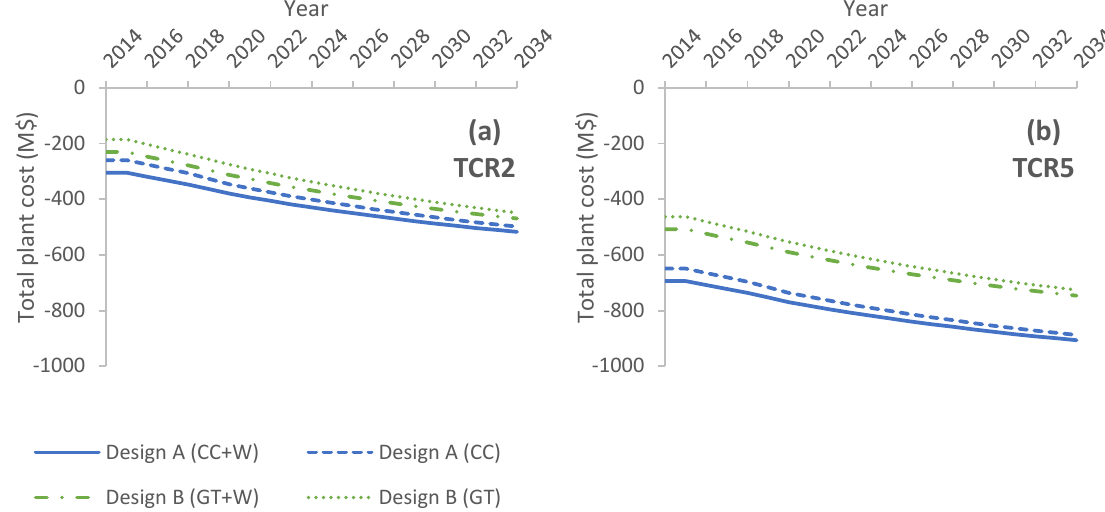
Figure 12. Evolution of the total plant cost throughout plant’s lifetime when the total capital requirement of the onsite power generation unit is increased by ( a ) a factor 2 (TCR2) or ( b ) 5 (TCR5). Discount rate ( r ). The effect of a lower (5%) and higher (9%) discount rate was evaluated.